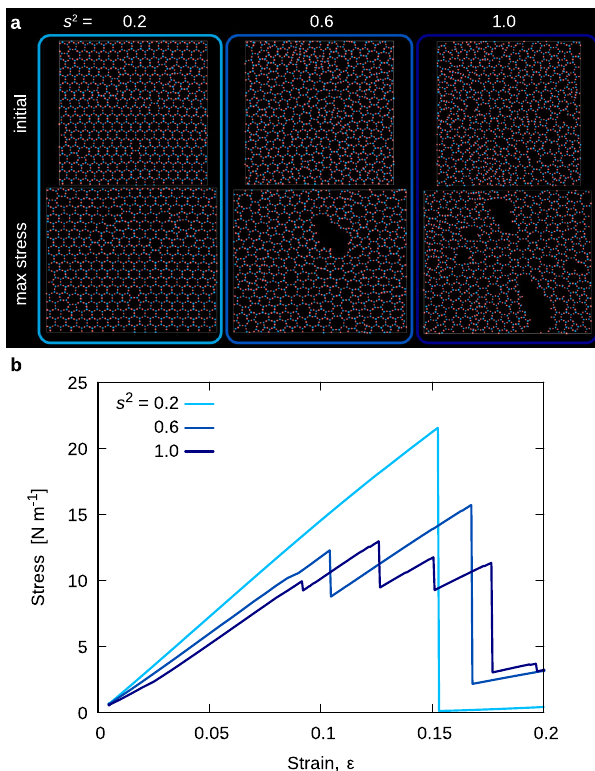
Fig. 2 Straining of silica samples. a Three typical con fi gurations of silica samples with different disorder levels s 2 = 0.2, s 2 = 0.6, and s 2 = 1.0. We report the initial con fi guration and the con fi guration corresponding to the peak stress. b Stress-strain curves for the samples corresponding to panel A. The stress is measured in N/m considering a two-dimensional system of area L x ⋅ L y , where L x and L y are the cell longitudinal and transversal size of the initially relaxed (unstrained) con fi guration. As the disorder increases, the stress-strain curves become less